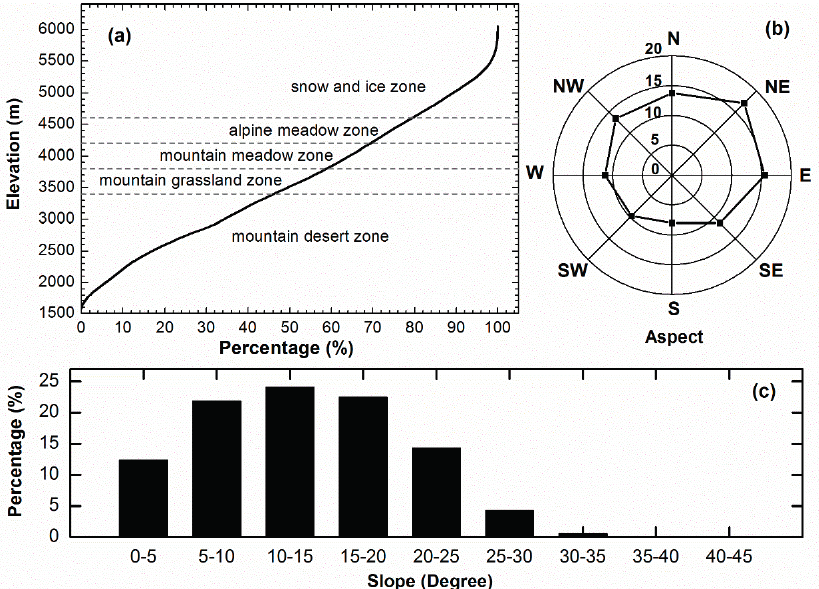
Figure 2. ( a ) Hypsometric curve, ( b ) area percentages of slope bands, and ( c ) aspect rose diagram of the Tizinafu